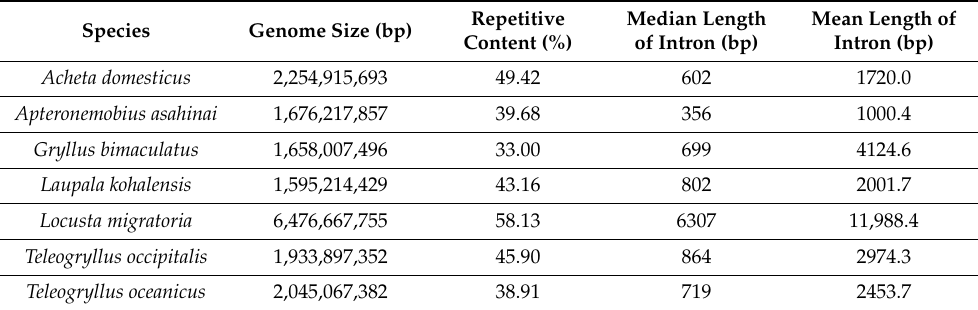
Table 2. Comparison of the size of the genome of orthopteran species, repetitive content, and the mean length of